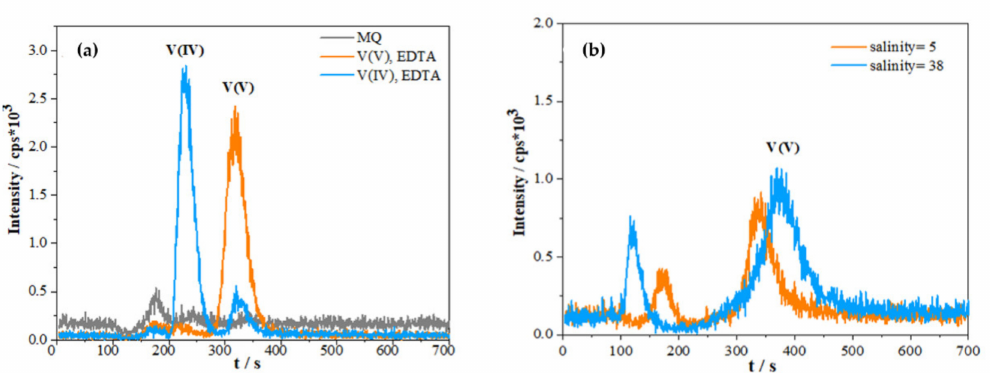
Figure 1. ( a ) Chromatograms of solutions containing 40 nmol L − 1 V(V) (orange line) and 40 nmol L –1 V(IV) (blue line) in MQ water with the EDTA added in solution (3 mmol L − 1 , pH = 7) compared to blank (MQ water, grey line) using IC–ICP–MS. ( b ) Comparison of chromatograms obtained by IC-HR ICP-MS at different salinities; total V and V(V) concentration measured in samples collected at “Vrnaža port” (VP) sampling station (orange line: environmental sample of salinity = 5, V tot = 24.5 ± 1.4 nmol L − 1 , V(V) = 21.8 ± 0.1 nmol L − 1 ; blue line: environmental sample of salinity = 38, V tot = 37.0 ± 0.8 nmol L − 1 , V(V) = 31.1 ± 3.34 nmol L − 1 ). All chromatograms ( a , b ) were measured using the following eluent composition: 40 mmol L − 1 HCO 3 – , 40 mmol L –1 SO 4 2– , 8 mmol L –1 EDTA and 3%